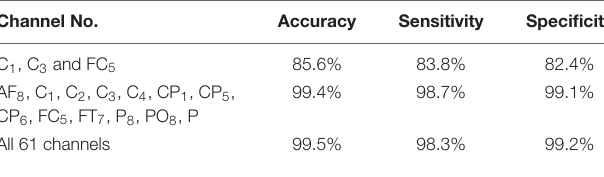
TABLE 8 | Classification accuracy based on the number channels. Channel